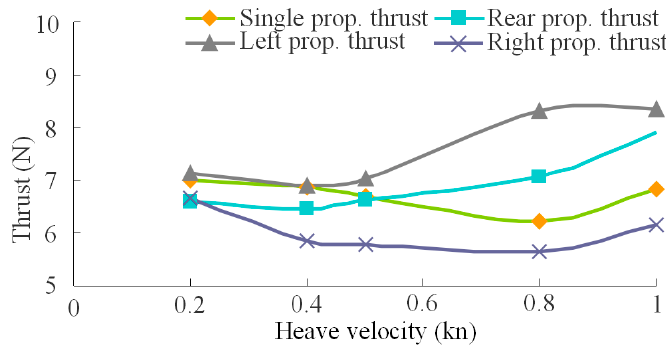
Figure 14. The vertical deep motion of each propeller thrust